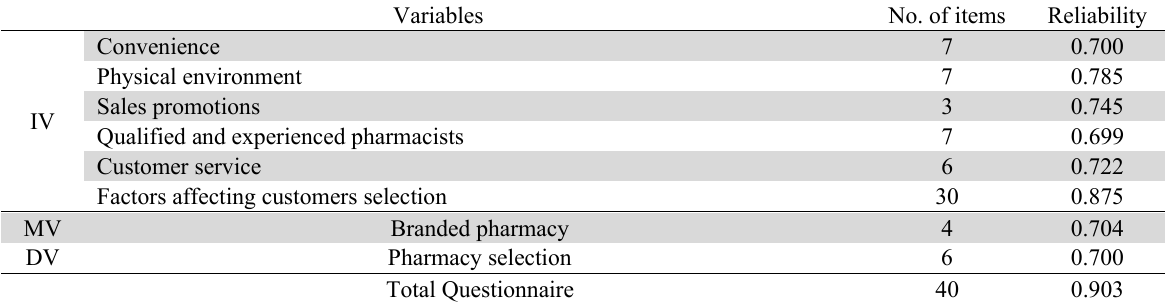
Table 3 indicates the results of Cronbach alpha reliability. The values ranged between (0.699) for qualified and experienced pharmacists to (0.875) for the factors affecting customers’ selection of pharmacie s (IV). These values reflect a good level